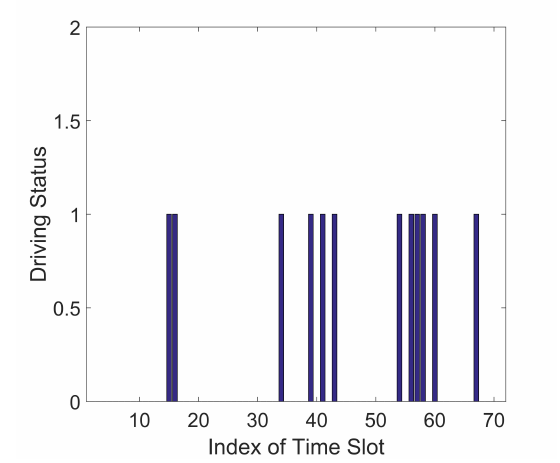
Figure 7. Driving status in 72 time slots. For each slot, it presents one hour. The value of “1” means the vehicle is being used, while “0” means that the vehicle is being not